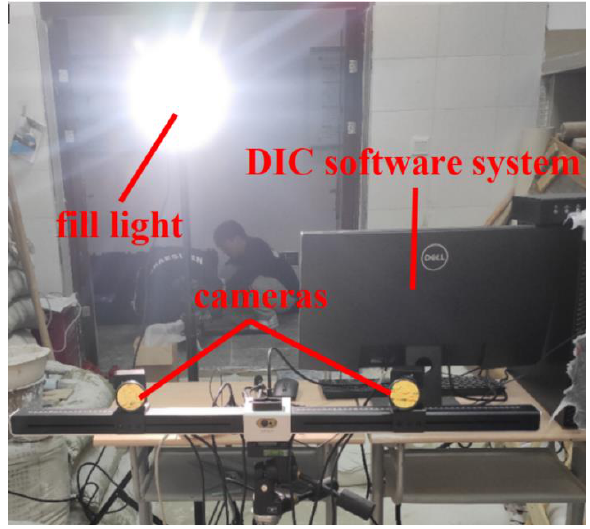
Figure 16. Digital image correlation.